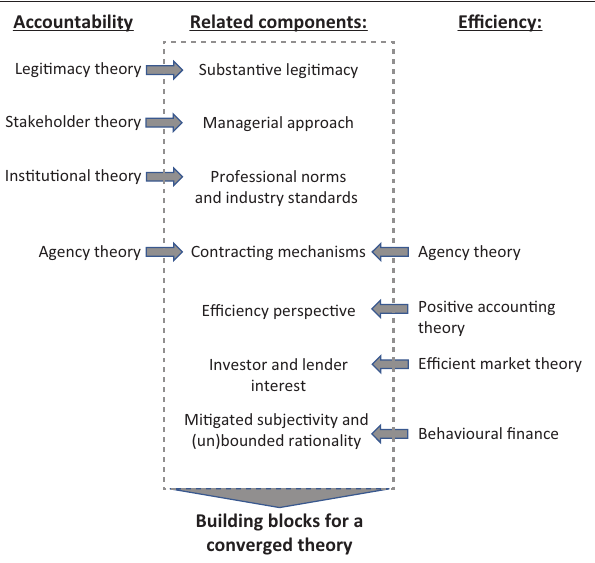
FIGURE 1: Building blocks of the proposed aspirational efficiency